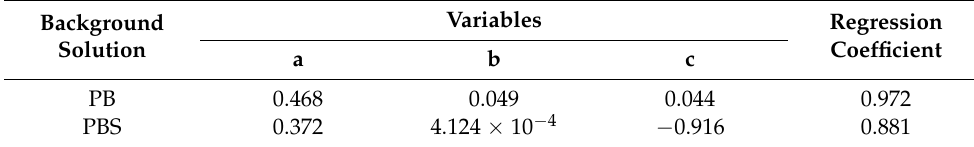
Figure 6. Adsorption kinetics curves (solid squares and circles) of the probe DNA immobilization on functionalized Graphene Field-Effect Transistors (GFET) sensor surface measured in two different electrolyte backgrounds. The solid lines are fittings to the Langmuir isotherm. Table 2. The pDNA adsorption kinetic variables measured in different